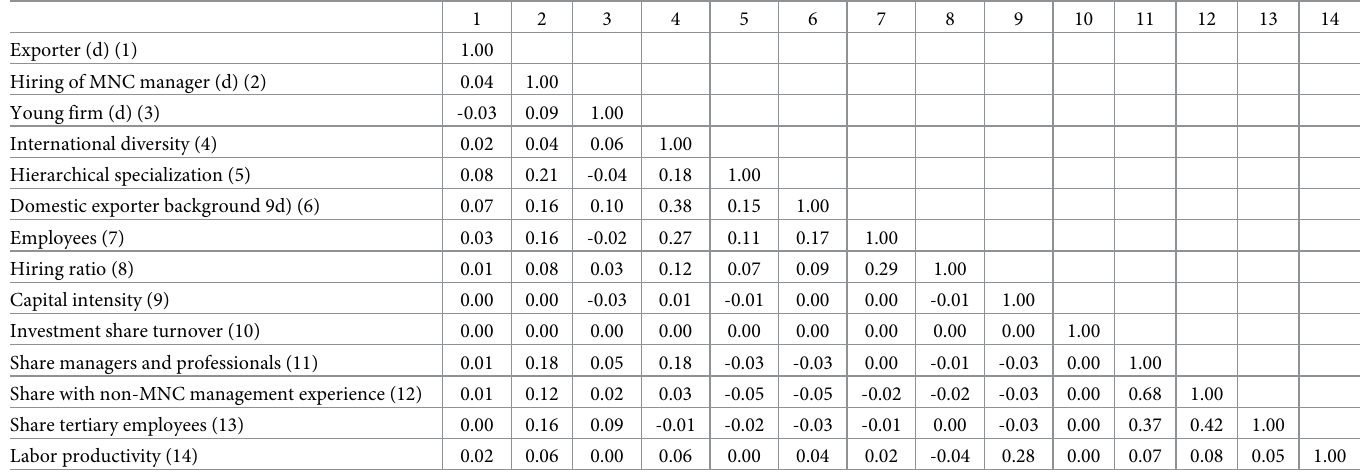
Table 2. Correlation